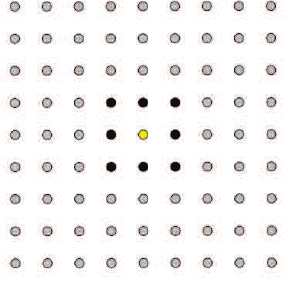
Figure 1. Illustration of the spatially-adjacent nodes. The yellow one denotes the given node and the black ones denote the eight spatially-adjacent